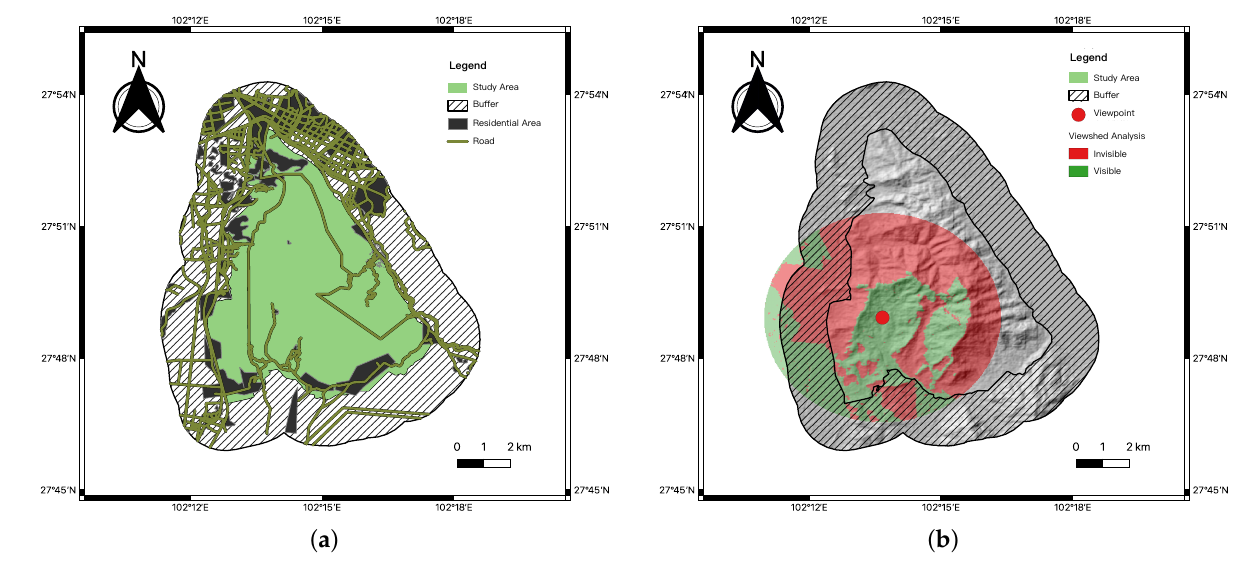
Figure 3. Viewshed Extraction; ( a ) Roads and residential areas; ( b ) Visual